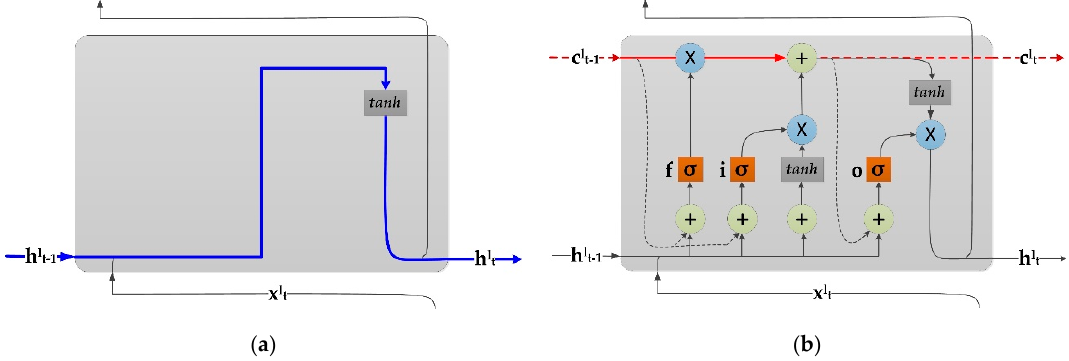
Figure 1. A comparison between Recurrent Neural Network (RNN) and Long Short-Term Memory (LSTM) blocks. ( a ) The internal structure of the RNN block. The bold blue line indicates that RNN blocks store memories in the form of hidden state activation. ( b ) The internal structure of the LSTM block. Dashed lines indicate peephole connections. The bold red line denotes that the LSTM block retains memories in the form of memory cell states, and memory cell states across two consecutive time steps are linearly related by the gating unit.